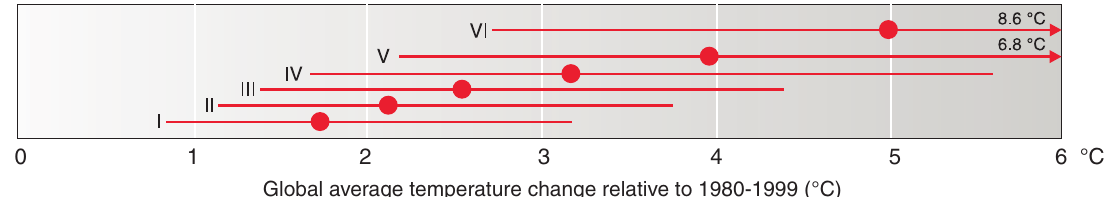
-eq; category IV 2